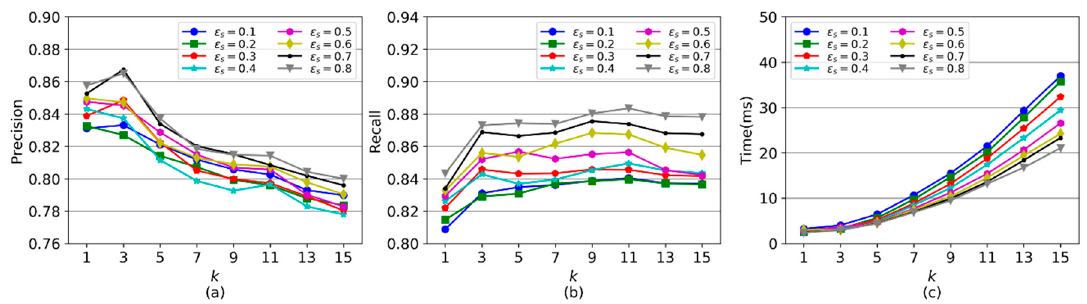
Figure 12. The performance of CMM with different values of 𝑘 and 𝜀 (cid:3046) . ( a ) Precision. ( b ) Recall. ( c ) Running time. ( c ) Running time.